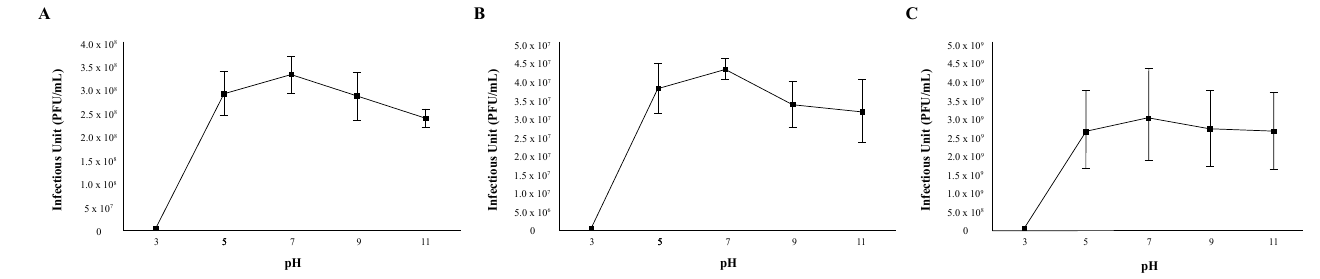
Figure 2. pH stability of phages. Error bars depict the standard deviations between the titers generated from three independent assays: ( A ) KaiHaiDragon; ( B ) OneinaGillian; ( C ) YuuY.